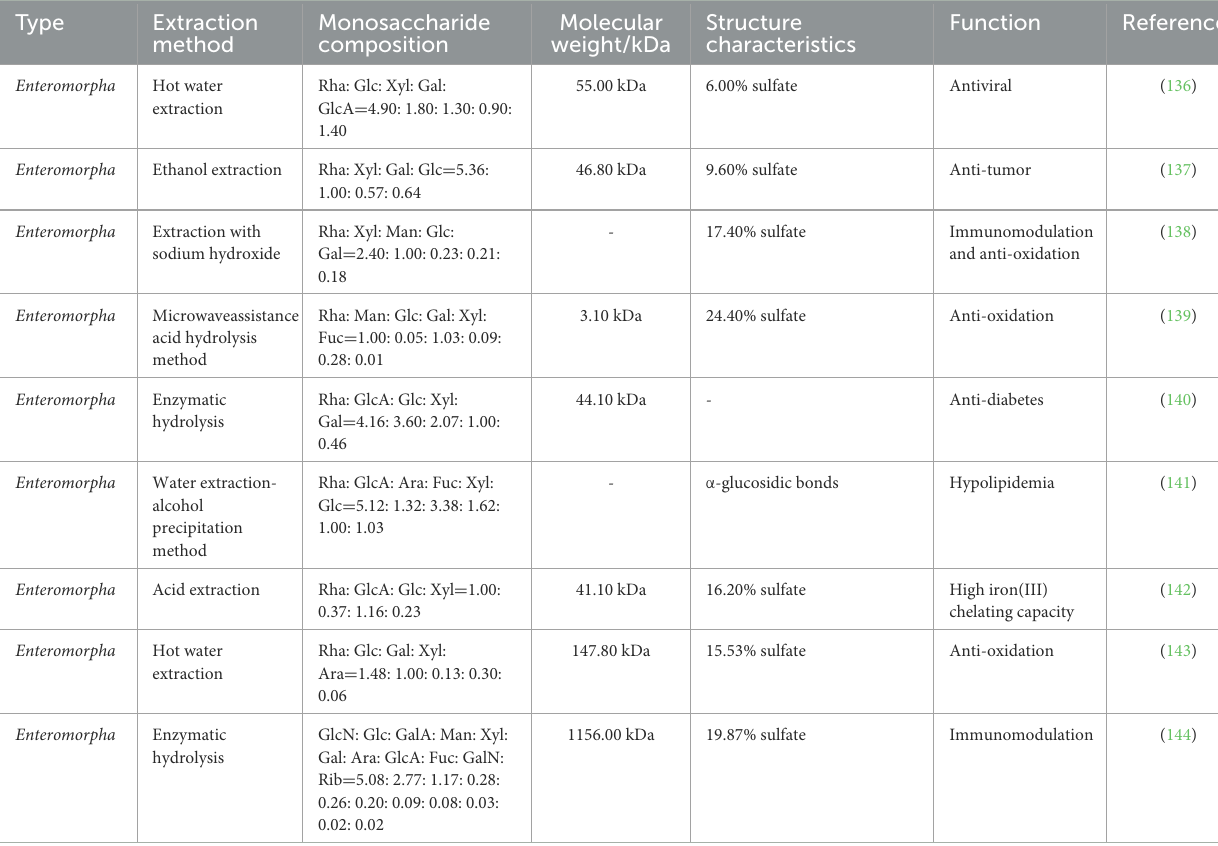
TABLE 8 Structure and structure-activity-relationship of polysaccharide from Enteromorpha